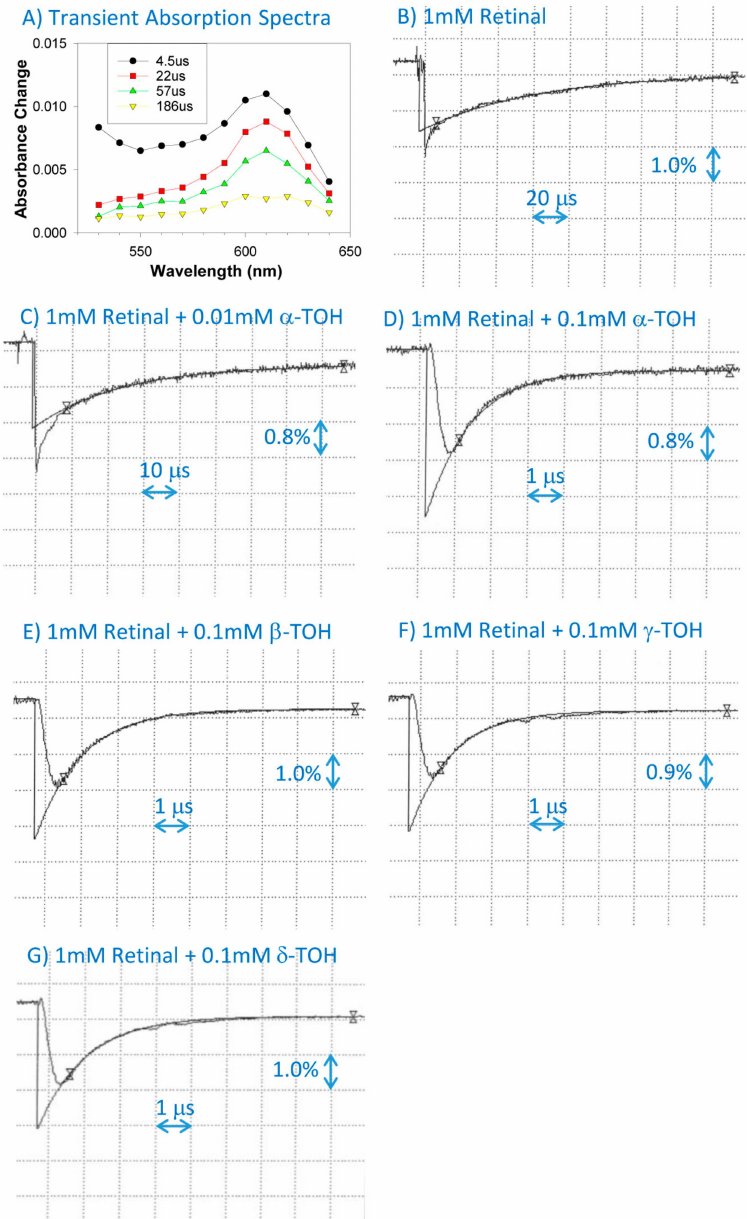
Figure 1. Transient absorption spectra at indicated times after the pulse radiolysis of N 2 O-saturated benzene with solubilized 1 mM of retinal ( A ), and representative kinetics of the formation and decay of retinal cation radicals monitored at 610 nm ( B – G ) after pulse radiolysis in the absence and presence of α -tocopherol ( α -TOH), β -tocopherol ( β -TOH), γ -tocopherol ( γ -TOH), and δ -tocopherol ( δ